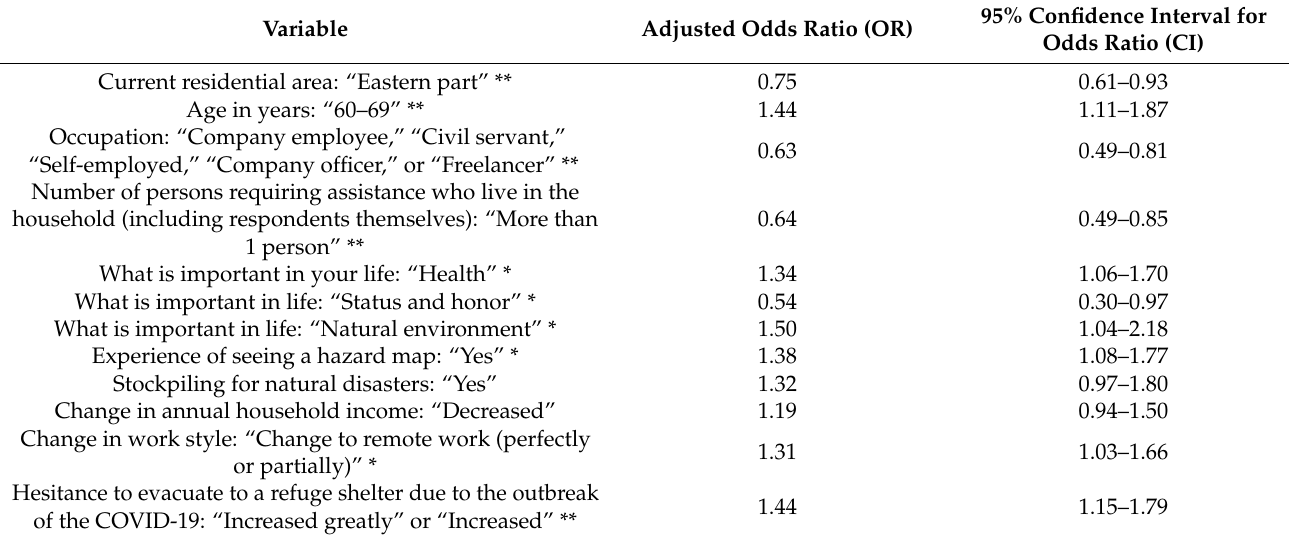
Table 5. Adjusted odds ratio and 95% confidence interval for individual variables to predict whether they ranked “safety against natural disasters” in the top category ( n = 1554). Note: only variables that scored p < 0.20 in the stepwise selection were retained. 95% Confidence Interval for Variable Adjusted Odds Ratio (OR) Odds Ratio (CI) 0.75